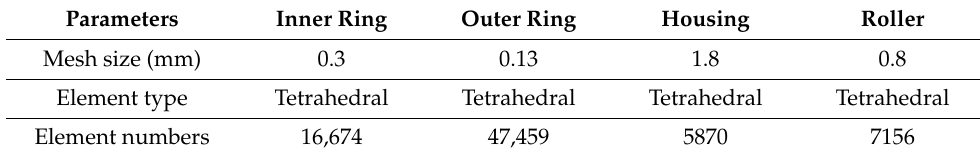
Table 2. The details of the numerical model.